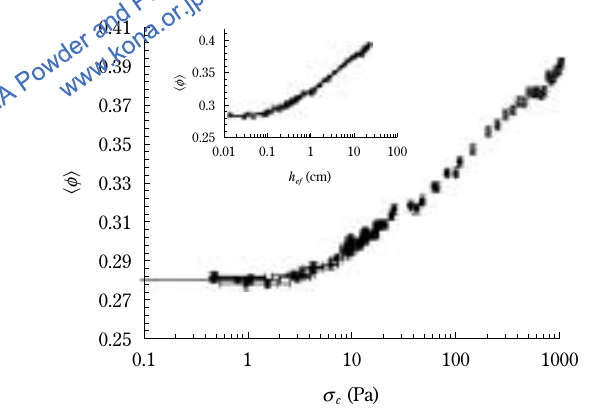
Fig. 4 Average particle volume fraction of a consolidated bed of Canon CLC700 toner as a function of the consolidation stress. The data obtained by reducing consolidation by means of an upward-directed gas flow (see below, solid symbols) are plotted jointly with data obtained by increas- ing consolidation by means of a downward-directed gas flow (see below, open symbols). The inset shows the whole set of data of the average particle volume fraction as a function of the effective depth measured from the top free surface, defined as h ef (cid:2) s c /( r p (cid:2) f (cid:3) g ) (the continuous curve represents the modified hyperbola fit equation (cid:2) f (cid:3) (cid:2) a (cid:7) , with a (cid:2) 1.366, b (cid:2) 1.088, c (cid:2) 3.968, d (cid:2)